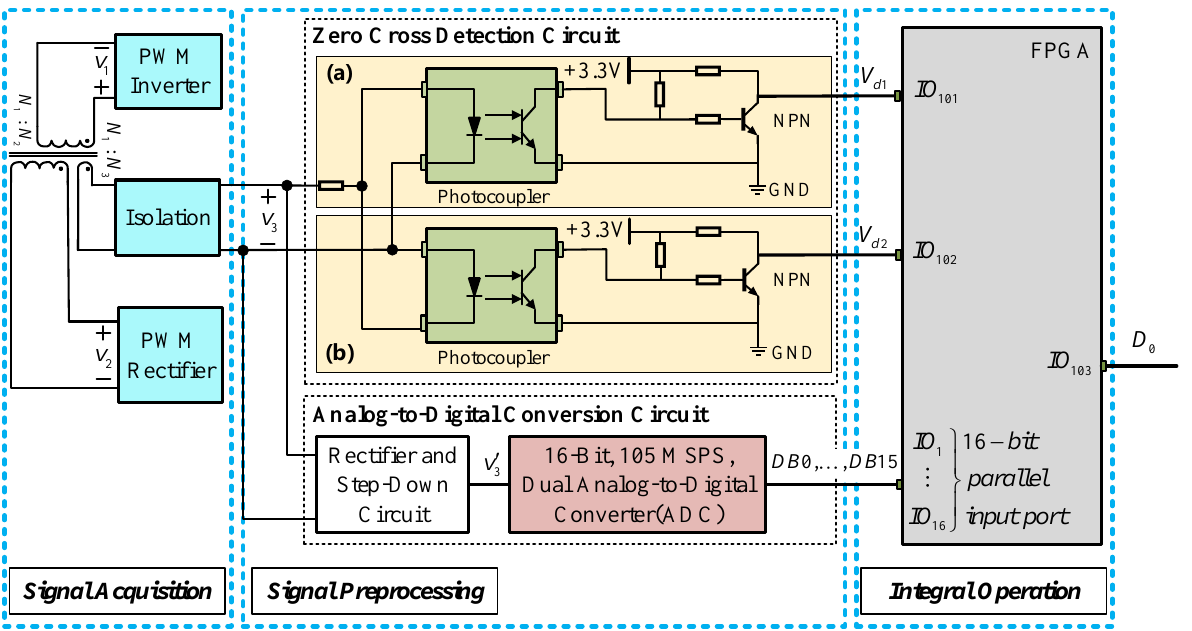
Figure 7. Long-time no zero drift digital integrator circuit block diagram. The long-time no zero drift digital integrator circuit is mainly composed of (1) Signal Acquisition Circuit, (2) Signal Pre-processing Circuit, and (3) Integral Operation